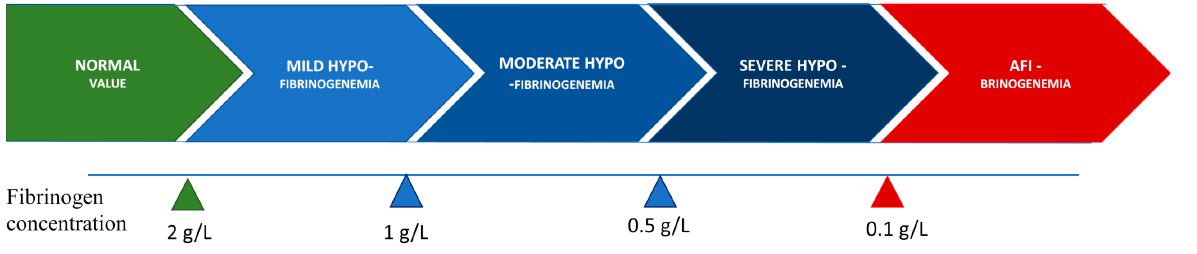
Figure 1. Classification of hypofibrinogenemia according to fibrinogen